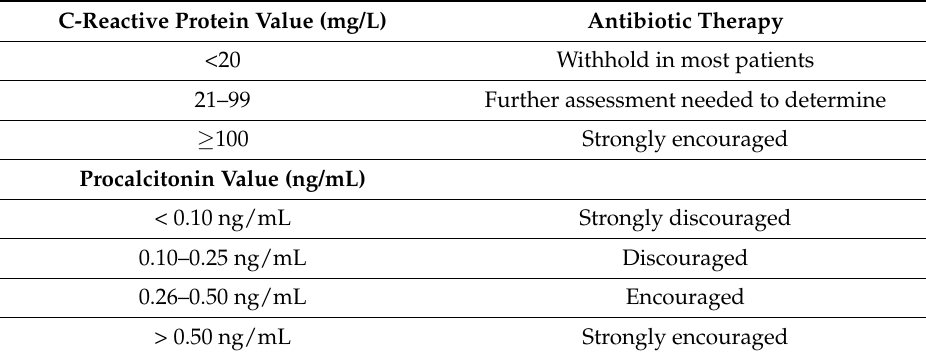
Table 1. C-reactive protein and procalcitonin levels and need for antibiotic therapy